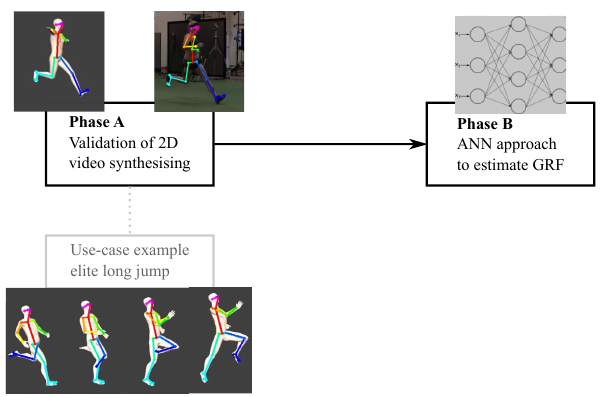
Figure 1. Design overview of the